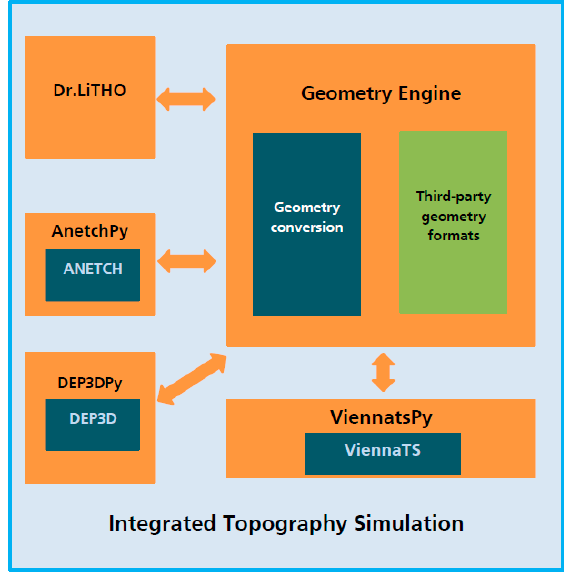
Figure 11. Integrated 3D topography simulation, combining Dr.LiTHO, DEP3D, ANETCH, and ViennaTS.